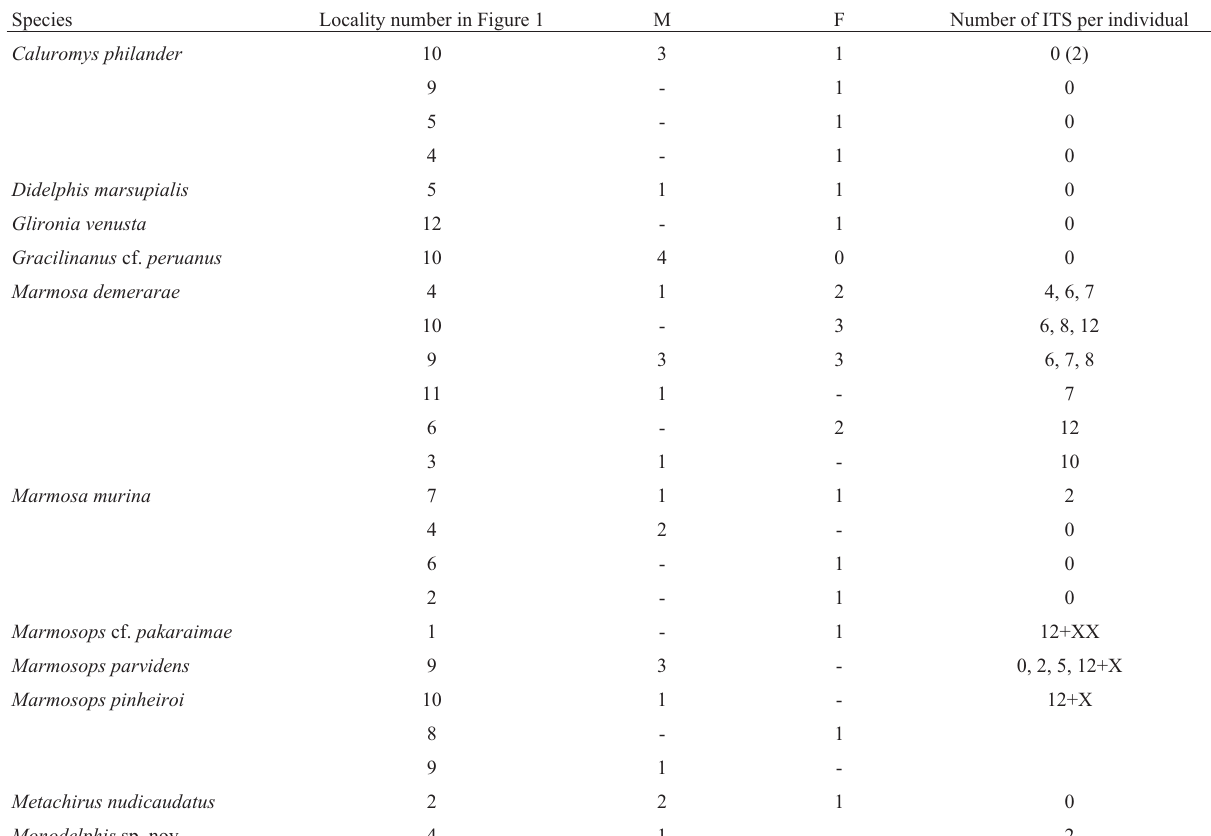
Table 1 - Species analyzed in the present study, and the code numbers correspond to the localities on the map (Figure 1).M= number of male individuals; F = number of female individuals; number of ITS = all counts recorded for the species at the respective locality.